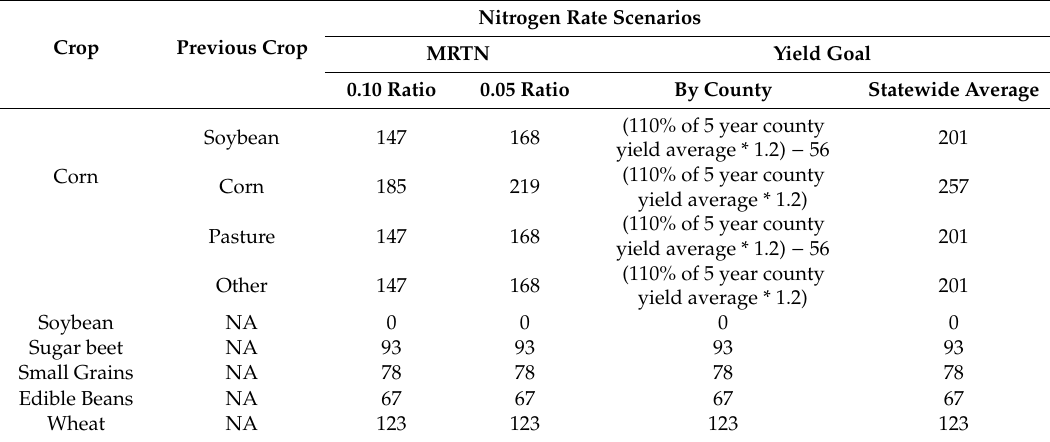
Table 2. Nitrogen Rates (kg ha − 1